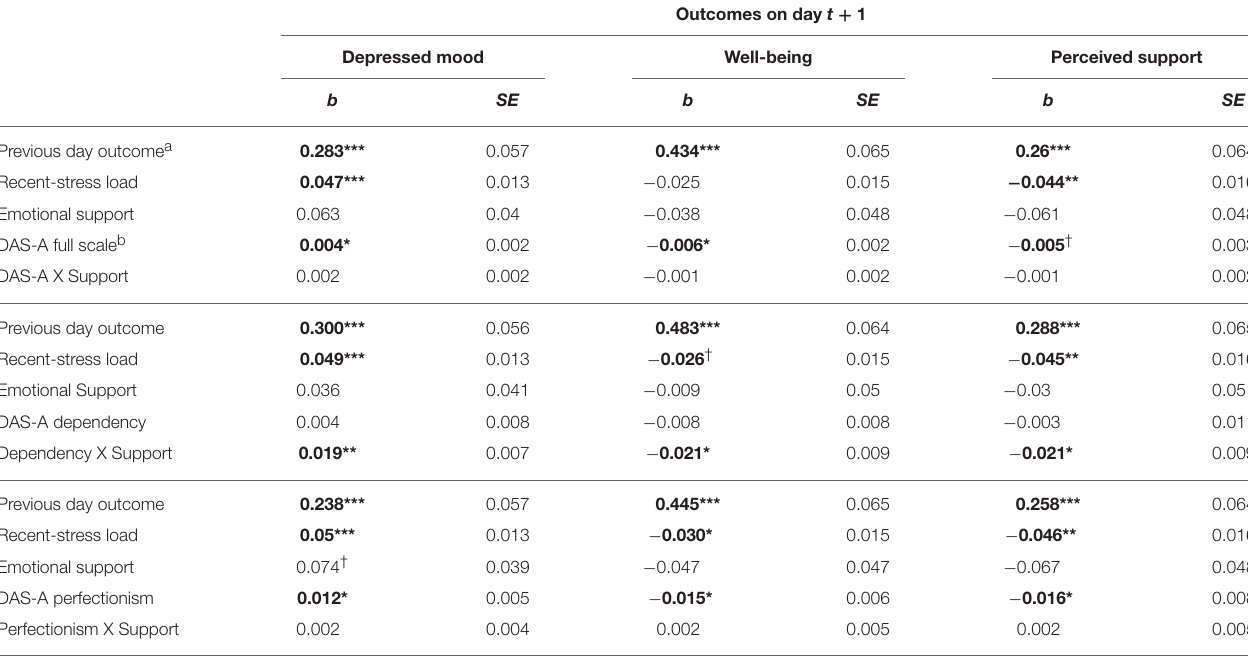
TABLE 3 | Regression coefficients for the effects of emotional support, dysfunctional attitudes, their interaction, and recent stress on change in mood and appraisals the day after a significant interaction with a